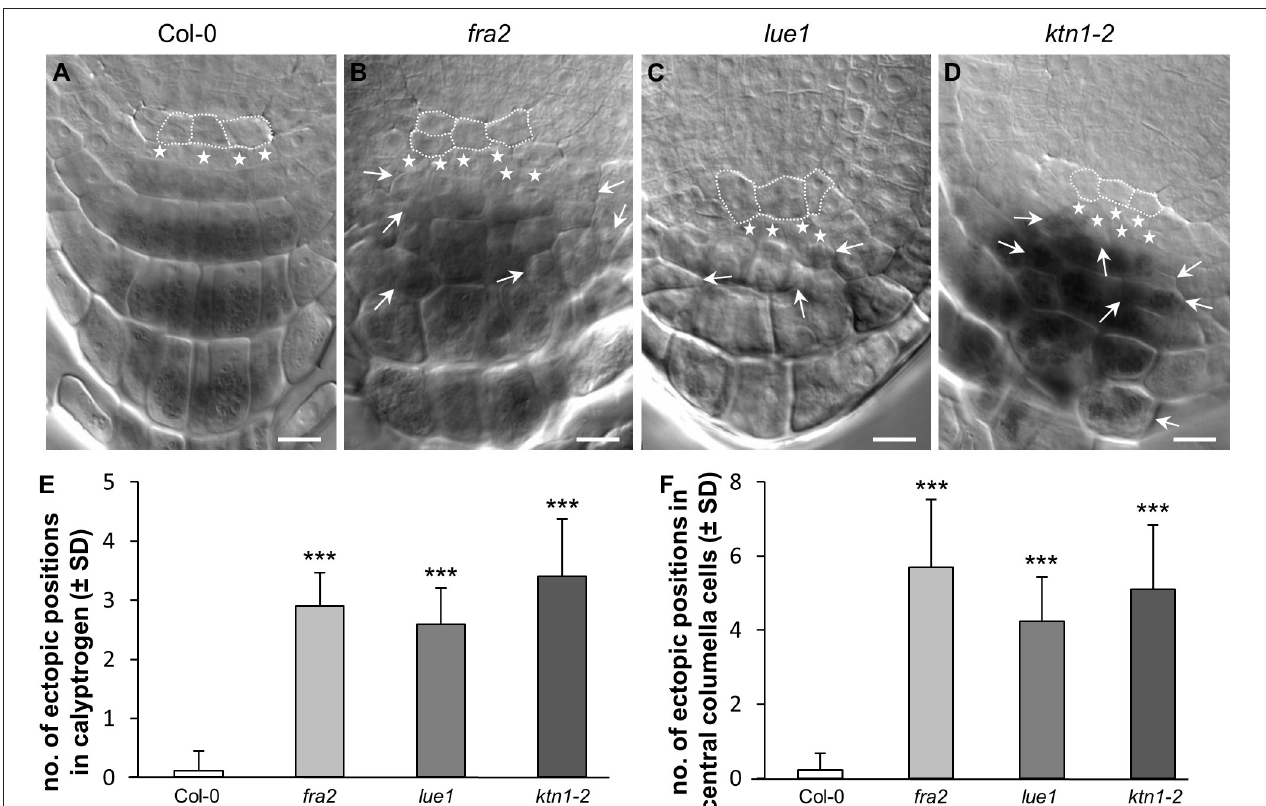
FIGURE 1 | Ectopic cell divisions in root calyptrogen and root cap malformations. (A–D) Organization of quiescent center and root cap in the root apex of Col-0 (A) , fra2 (B) , lue1 (C) , and ktn1-2 (D) mutants. Cells of the quiescent center are outlined by white dashed line, cells of the columella initials (calyptrogen) are indicated by white stars. Ectopic positions of differentiated cells in the columella are indicated by arrows. (E,F) Quantitative evaluation of ectopicaly positioned cells in the tiers of columella initials — calyptrogen (E) and in columella central cells (F) . Data for quantification were collected from 9–17 seedlings. Asterisks indicate statistical significance between measurements (*** p < 0.001). Bar: (A–D) 10 µ